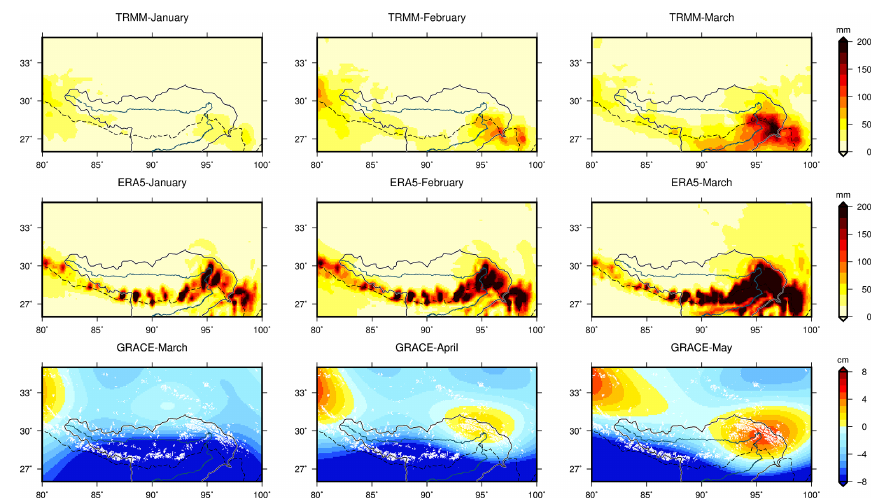
Figure 2. Monthly precipitation from January to March by TRMM and ERA5 and mass anomalies from March to May by GRACE. The Brahmaputra and its basin boundary are marked. The white shaded areas in the bottom plots represent glacier